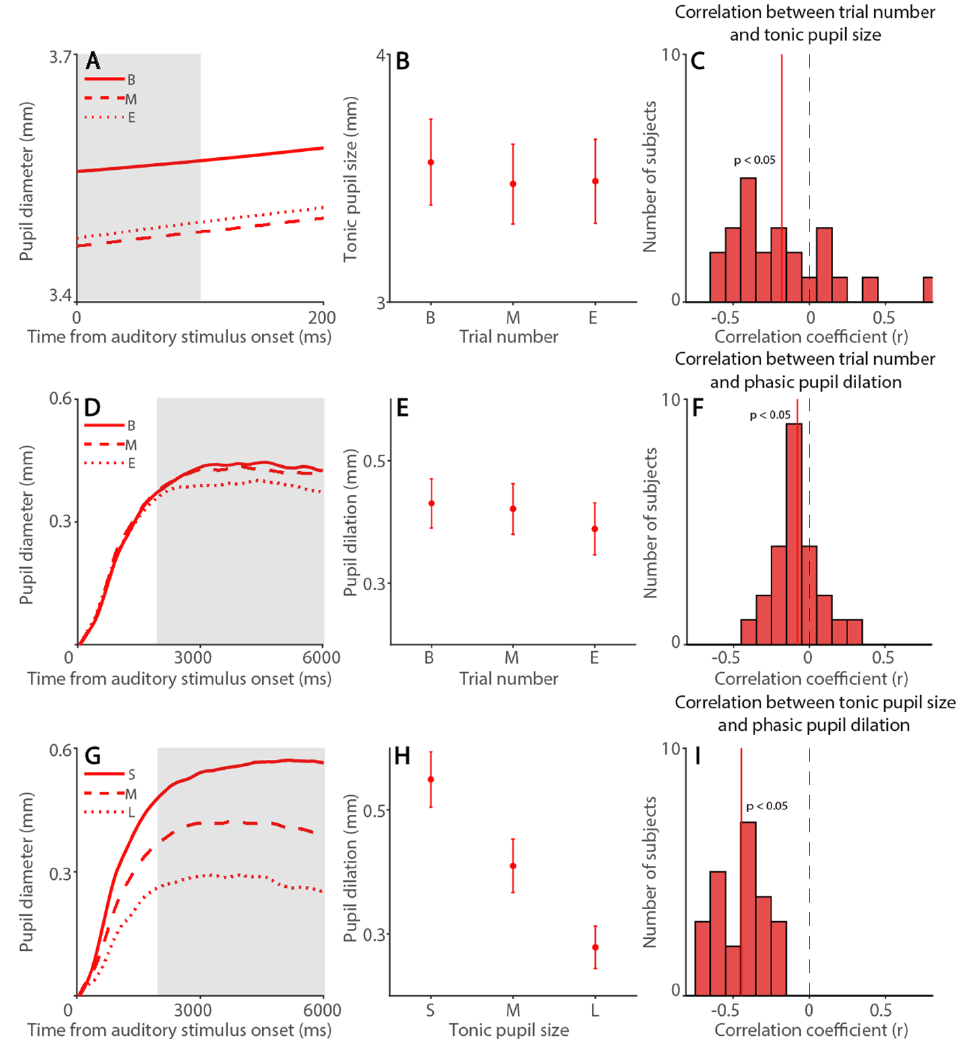
Figure 5. Tonic pupil size effects on tonic pupil size and phasic pupil dilation. ( A ) Dynamics of absolute pupil diameter following the presentation of emotional auditory stimuli. ( B ) Tonic pupil size (0 to 100 ms after emotional auditory stimulus onset) in different trial number conditions. ( C ) Distribution of correlation coefficients for the relationship between trial number and tonic pupil size for all subjects ( n = 24). ( D ) Changes in pupil diameter following the presentation of bright patch stimuli. ( E ) Pupil dilation size (2000 to 6000 ms after emotional auditory stimulus onset) in different trial number conditions. ( F ) Distribution of correlation coefficients for the relationship between trial number and phasic pupil dilation size for all subjects. ( G ) Changes in pupil diameter following the presentation of emotional auditory stimuli. ( H ) Pupil dilation size (2000 to 6000 ms after patch onset) in different tonic pupil size conditions. ( I ) Distribution of correlation coefficients for the relationship between tonic pupil size and phasic pupil dilation size for all subjects. In ( A , D , G ), the analyzed epochs are shaded in gray. In ( B , E , H ), the error bars represent ± standard error range (across participants). In ( C , F , I ), the vertical black dashed line represents a zero value of the correlation coefficient (r = 0), and the vertical colored line represents the mean value of the correlation